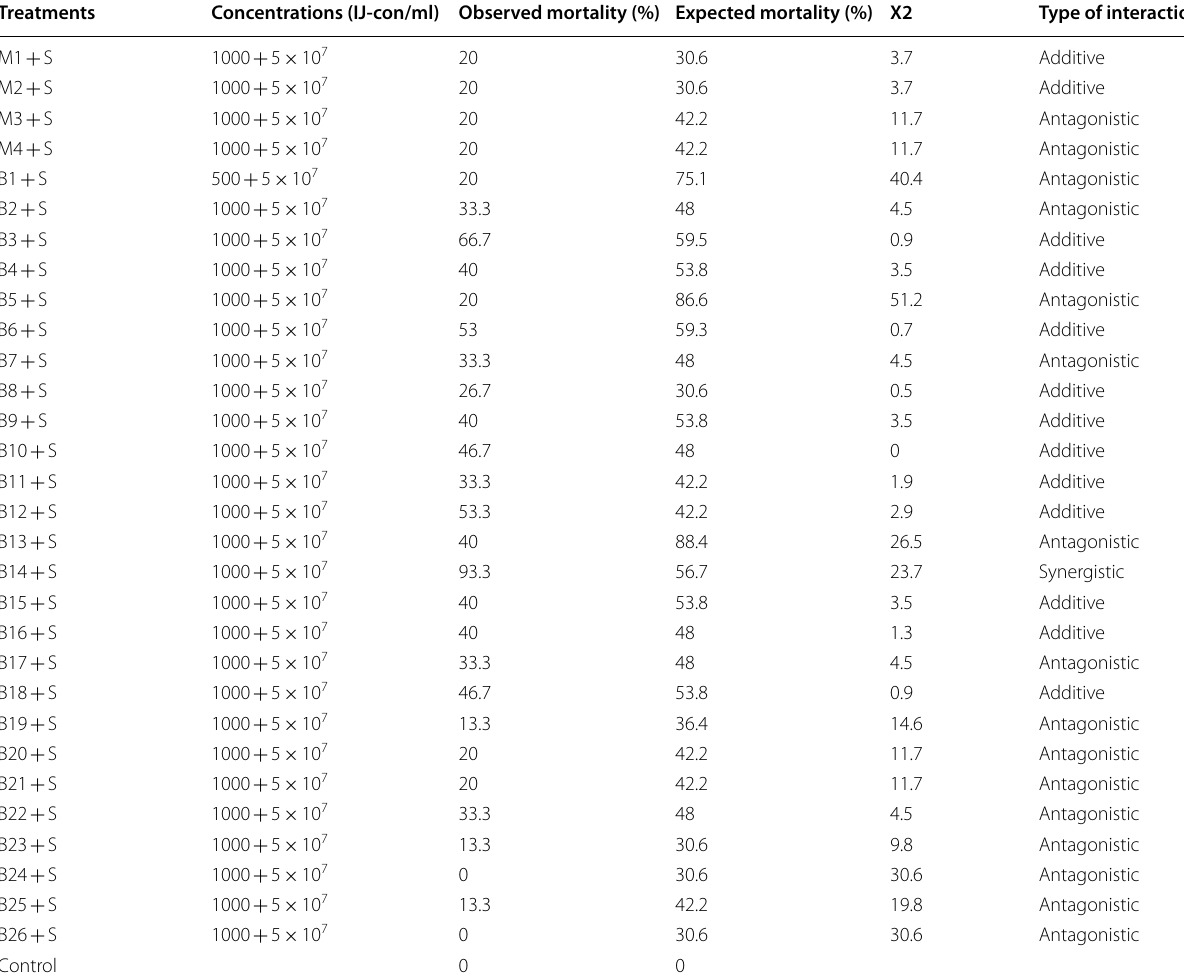
a X 2 : Chi-square test